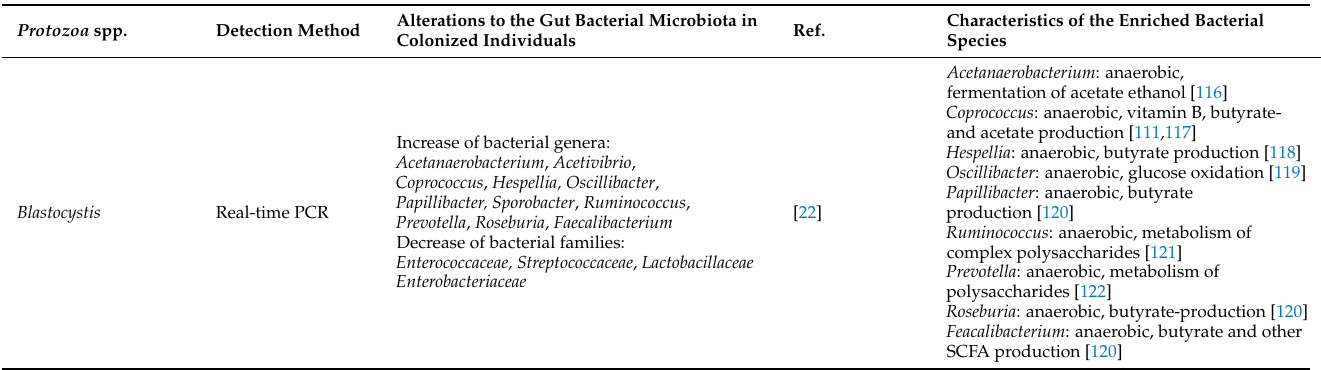
Table 2. Colonization with different protozoa species and the associated bacterial changes in healthy